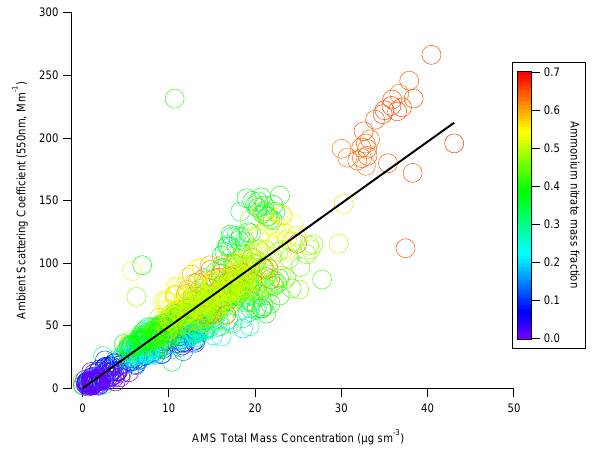
Fig. 8. Relationship between ambient light scattering and the total mass concentration derived from the AMS on the BAe-146. The solid black line indicates the slope of the linear regression analy- sis, which corresponds to an ambient mass scattering efficiency of 4.93m 2 g − 1 . The points are coloured according to the ammonium nitrate mass